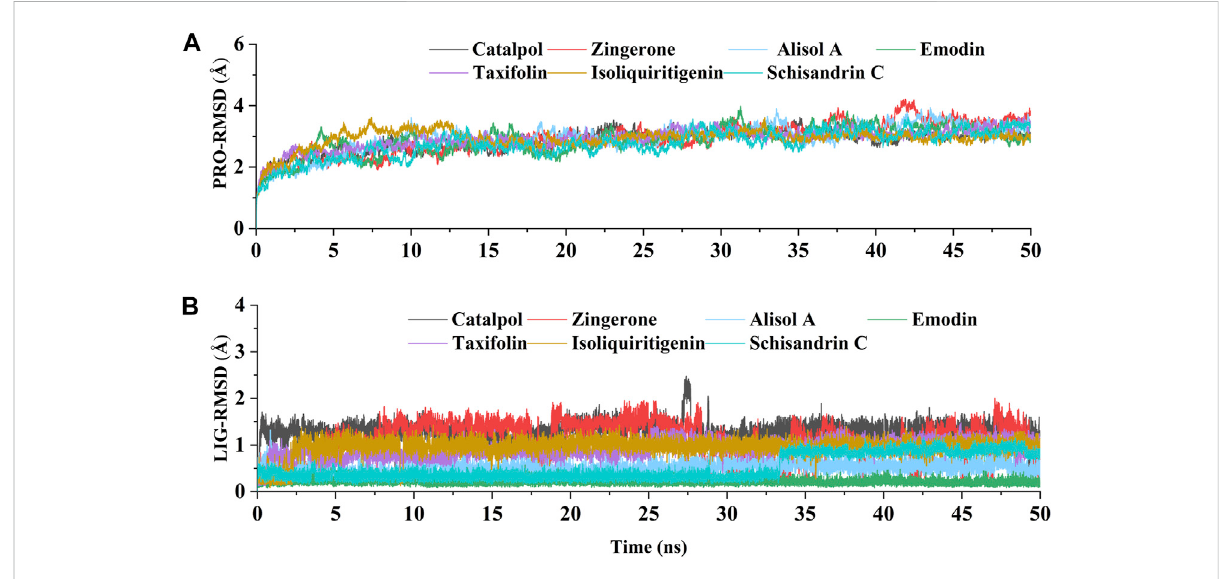
FIGURE 7 TheRMSDvaluesrelativetotheinitialstructure. (A) RMSDofthebackboneatomsofDNMT1ineachconstituents-DNMT1complex; (B) RMSDof the heavy atoms of seven potential active constituents in each constituents-DNMT1 complex.